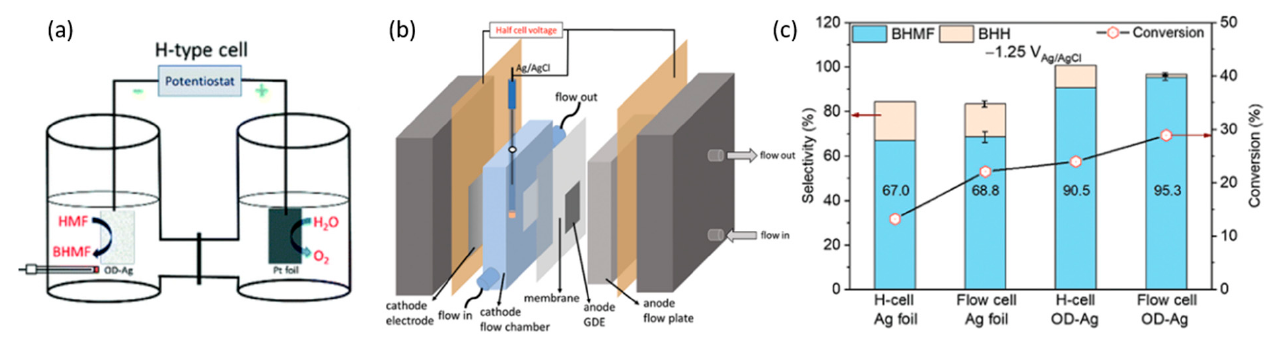
Figure 18. ( a ) H cell diagram. ( b ) Flow cell diagram. ( c ) BMHF and 5,5-bis(hydroxymethyl)hydrofuroin (BHH) results from 5-HMF hydrogenation using Ag or OD-Ag, in H cell or flow cell. Reprinted with permission from Ref [98]. Copyright 2021, Green Chemistry.